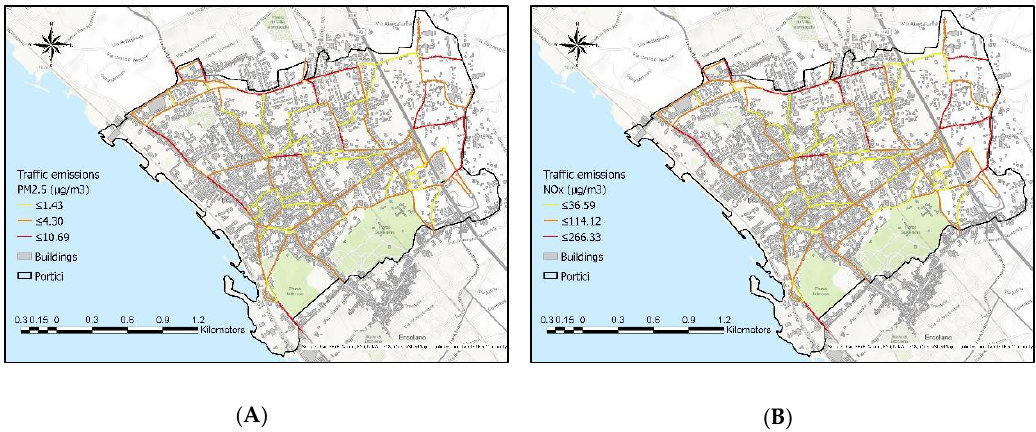
Figure 6. Layers of the traffic-related pollutant emissions simulated for a typical workday of October. ( A ) Map of the simulated traffic-related emissions of PM 2.5 pollutant. ( B ) Map of the simulated traffic-related emissions of NOx pollutant